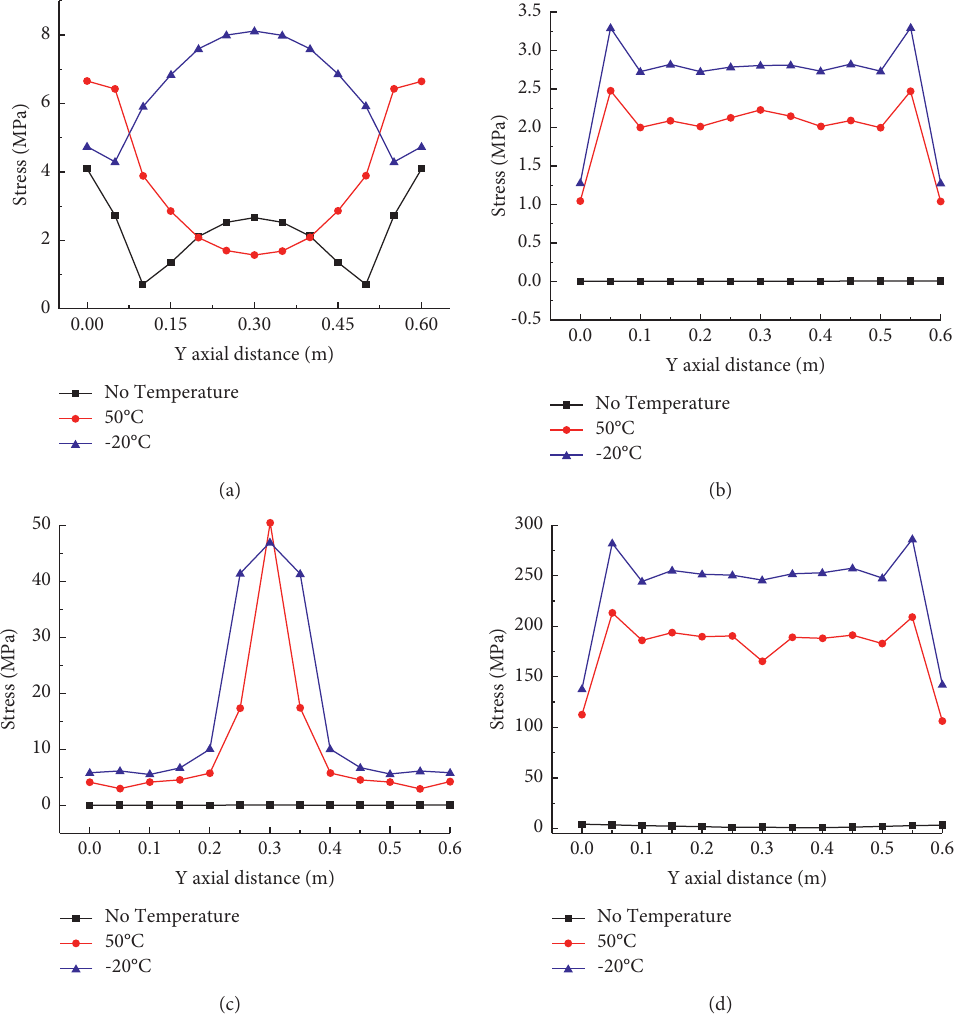
Figure 20: Comparison of Mises principal stress of the semirigid finish layer. (a) Face brick. (b) Bonding layer. (c) Insulation layer. (d) Interface layer.